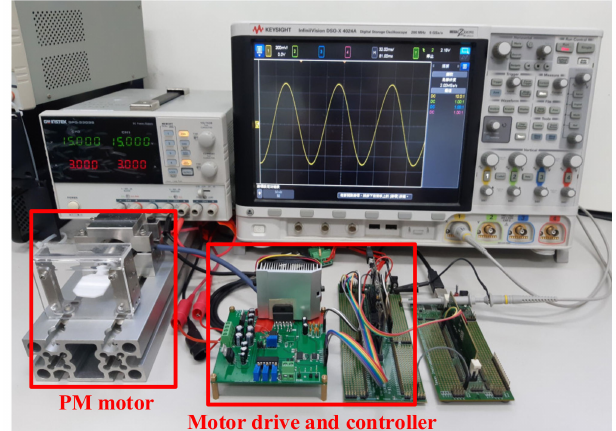
Figure 16. Photograph of PM motor test